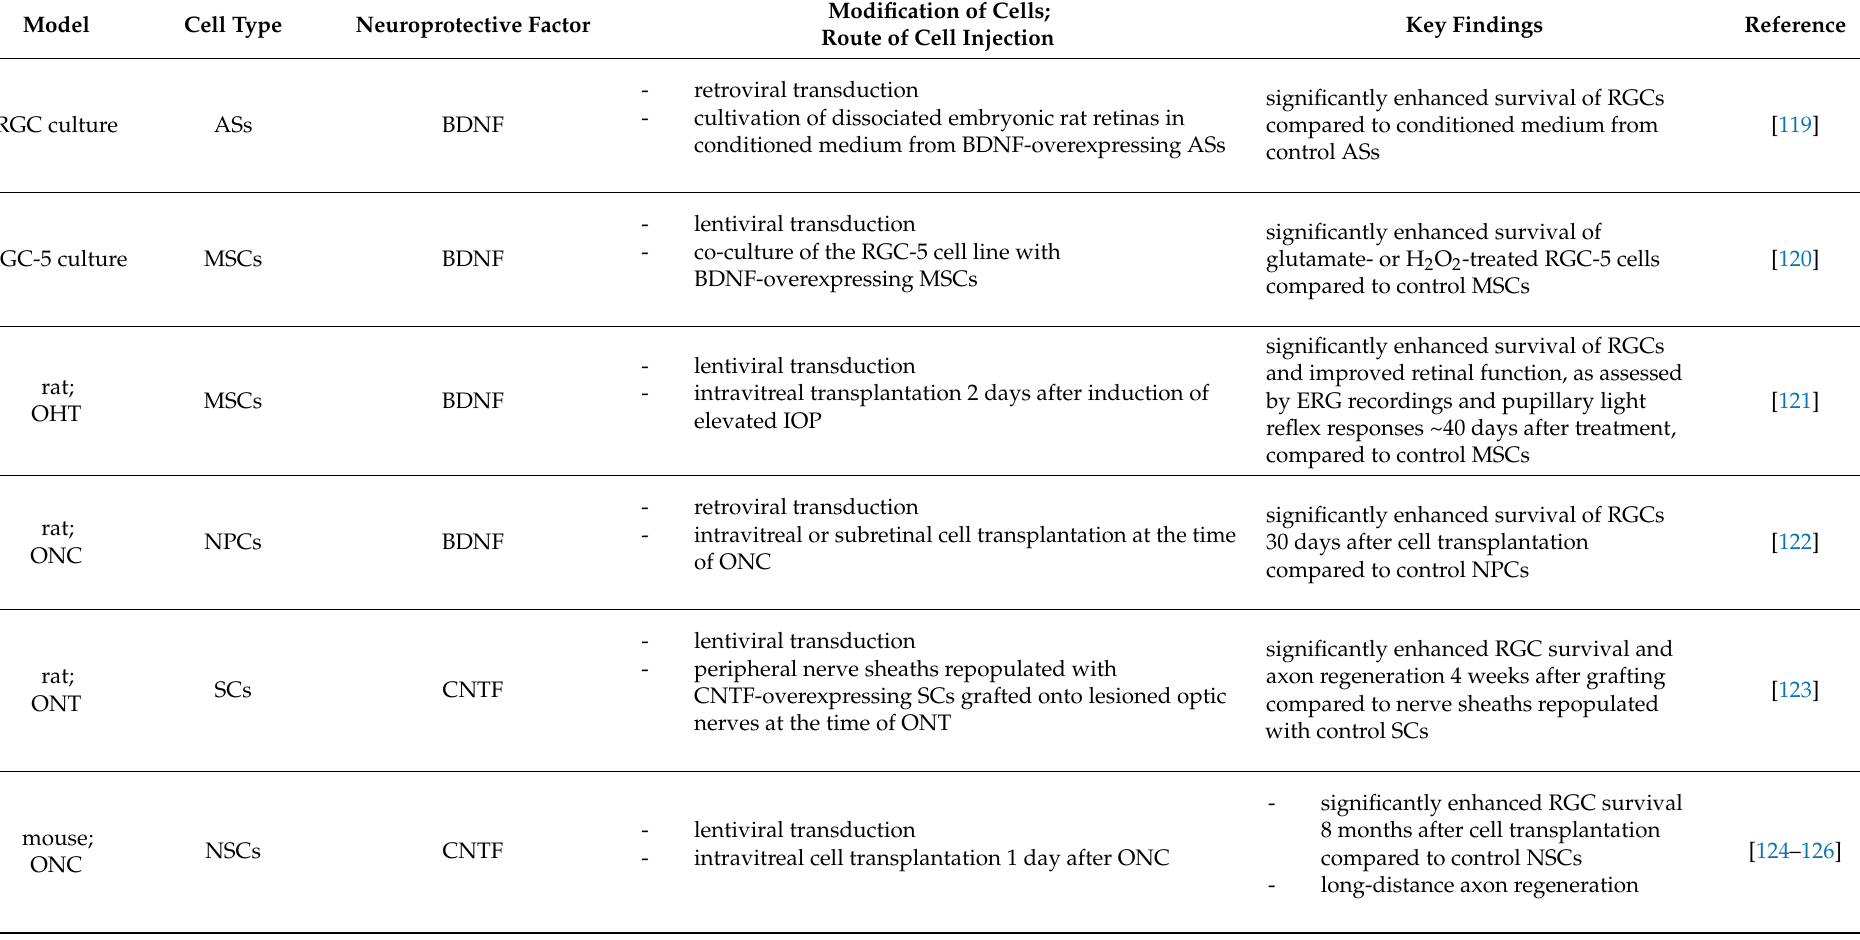
Table 1. Promotion of RGC survival with genetically modified cells in vitro and in